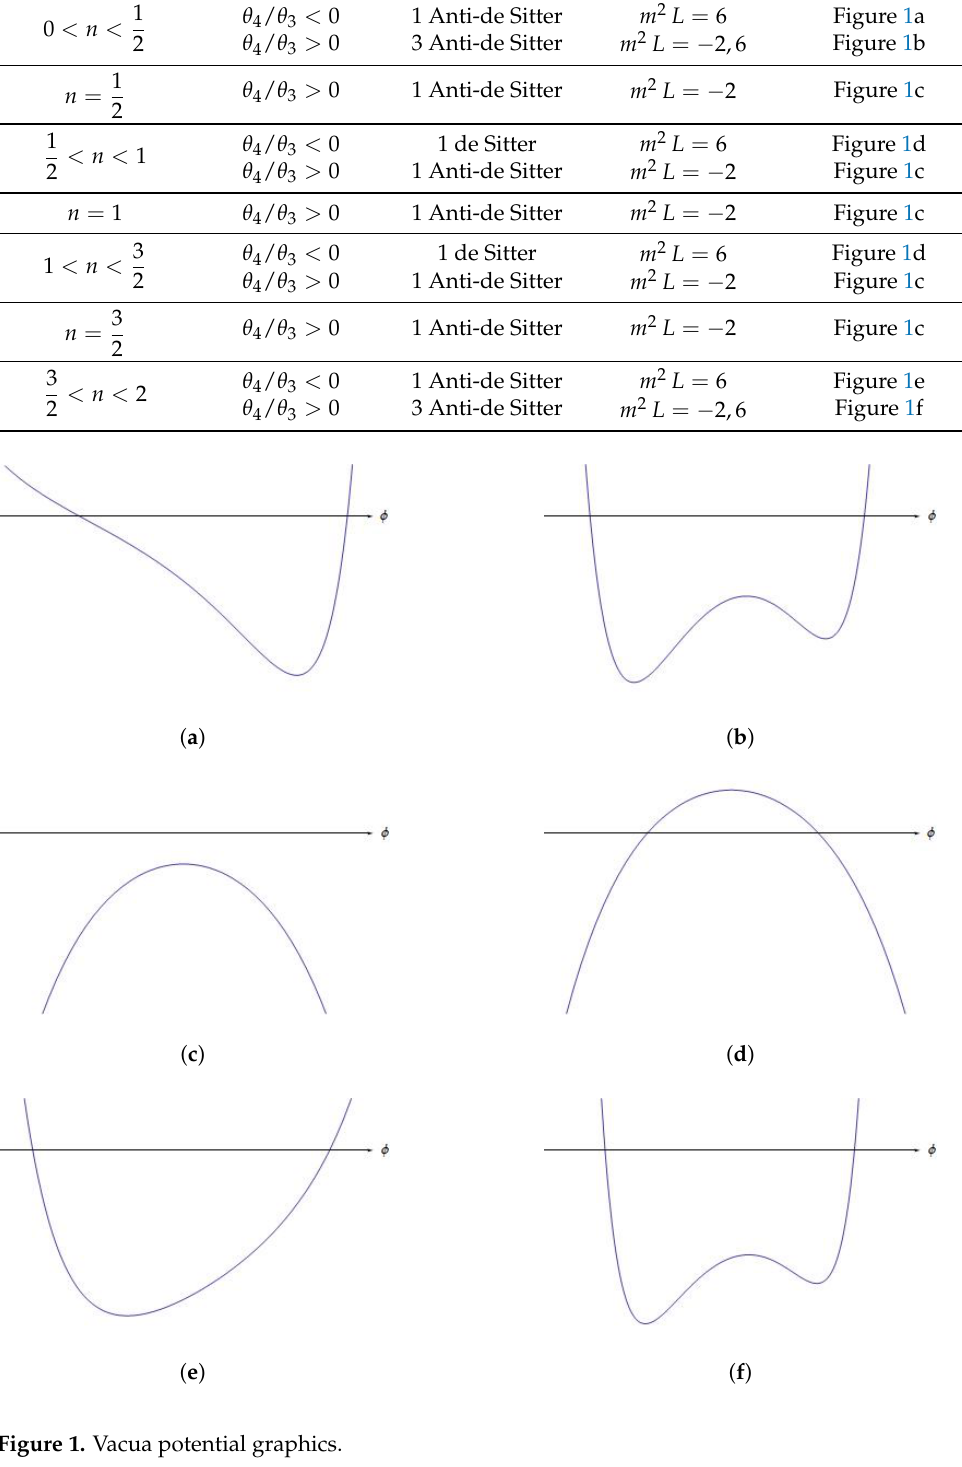
Figure 1. Vacua potential